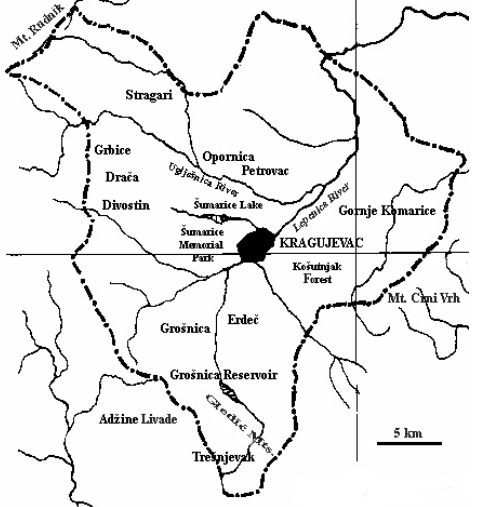
Figure 2. The City of Kragujevac with the important